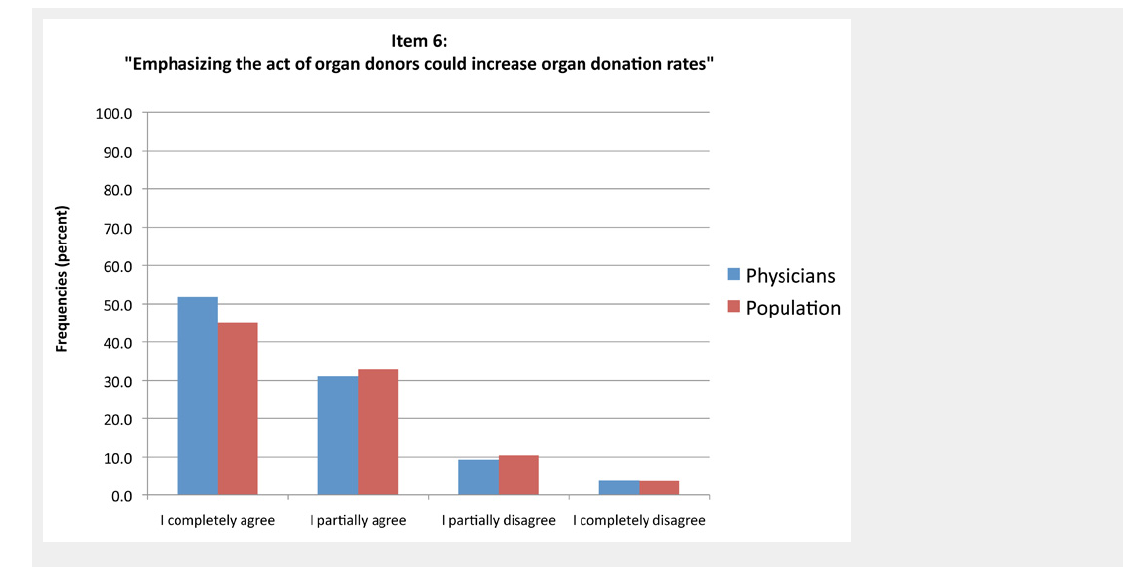
Figure 1 Distribution of the physicians’ and inhabitants’ answers for item 6.